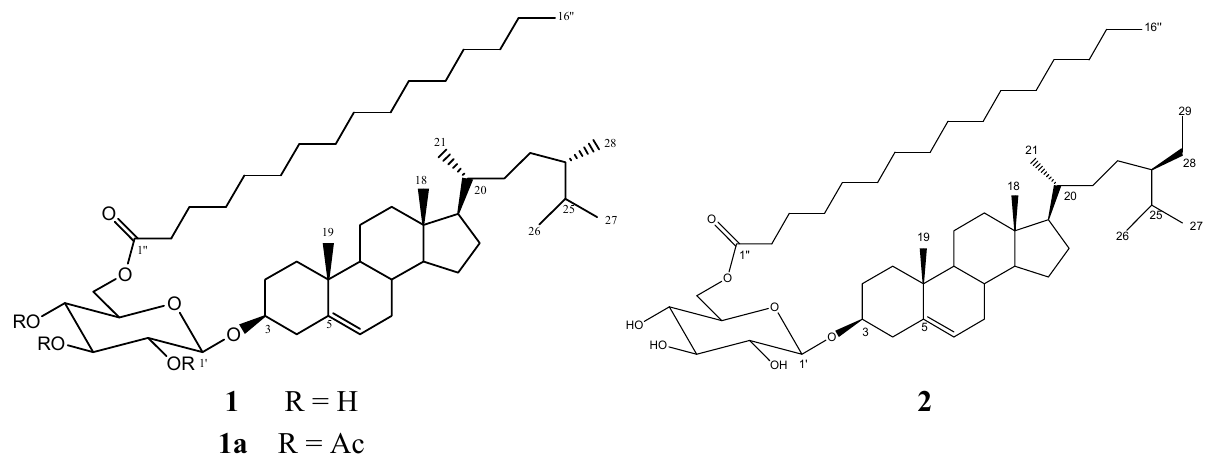
Figure 1. Chemical structure of compounds 1 and 2